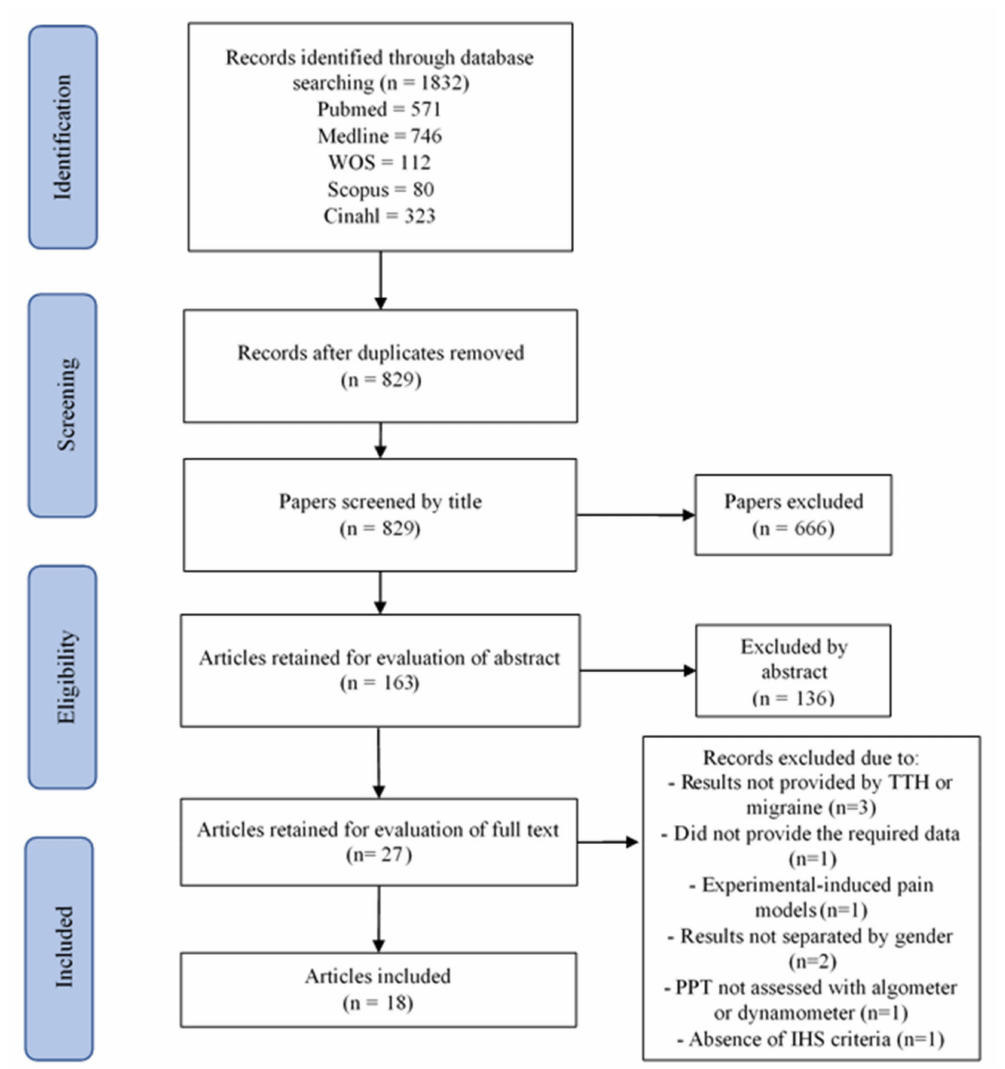
Figure 2. Migraine process. PRISMA Extension for Scoping Reviews (PRISMA-ScR) flow